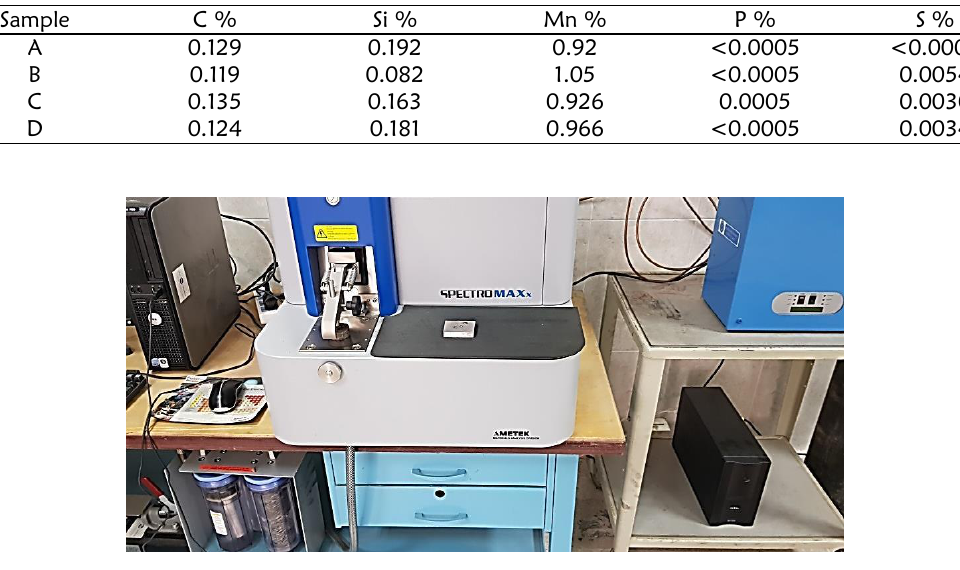
Figure 2: chemical composition of samples